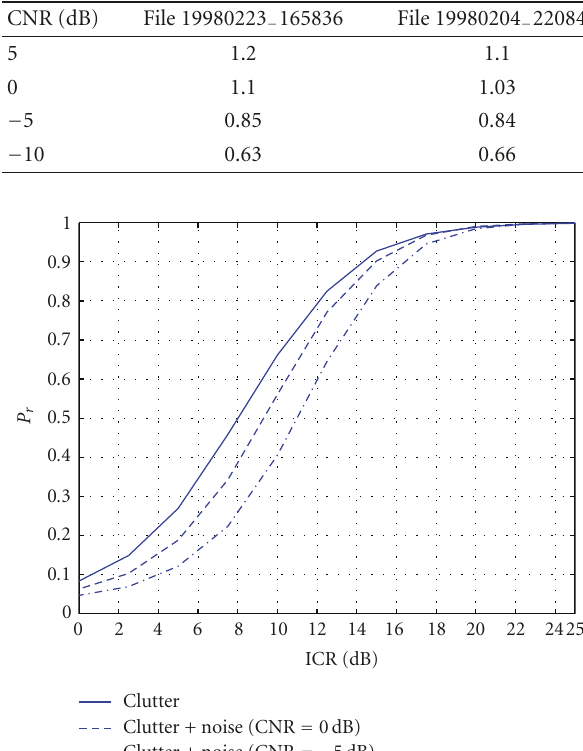
Table 10: The ratio P e /P e B = 50, and HH polarization.